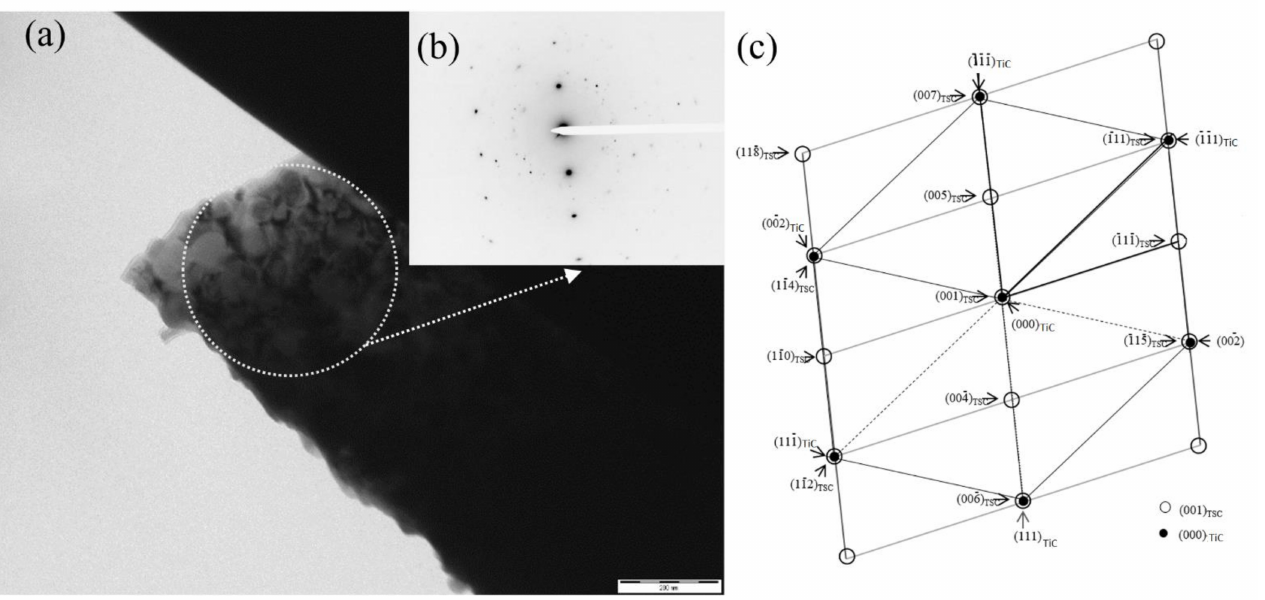
Figure 9. TEM images of the substructure of detonation coating based on Ti 3 SiC 2 after pulse-plasma treatment: ( a )—brightfield image of the thin structure of Ti 3 SiC 2 ; ( b )—microdiffraction pattern obtained of the selected area on ( a ); ( c )—indicated diagram.